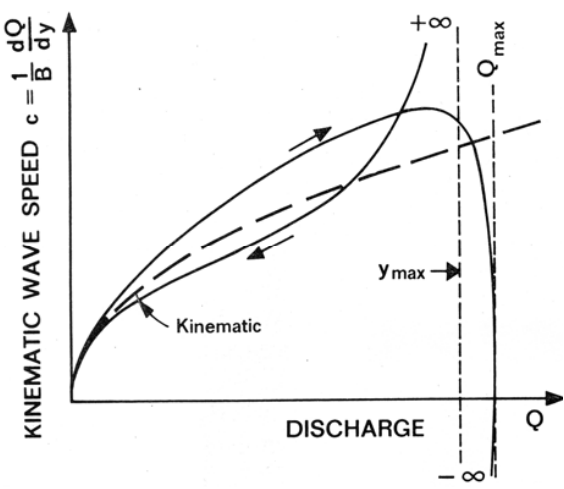
Fig. 2. Wave celerity from looped rating curve (Weinmann, 1977, adapted from Koussis,